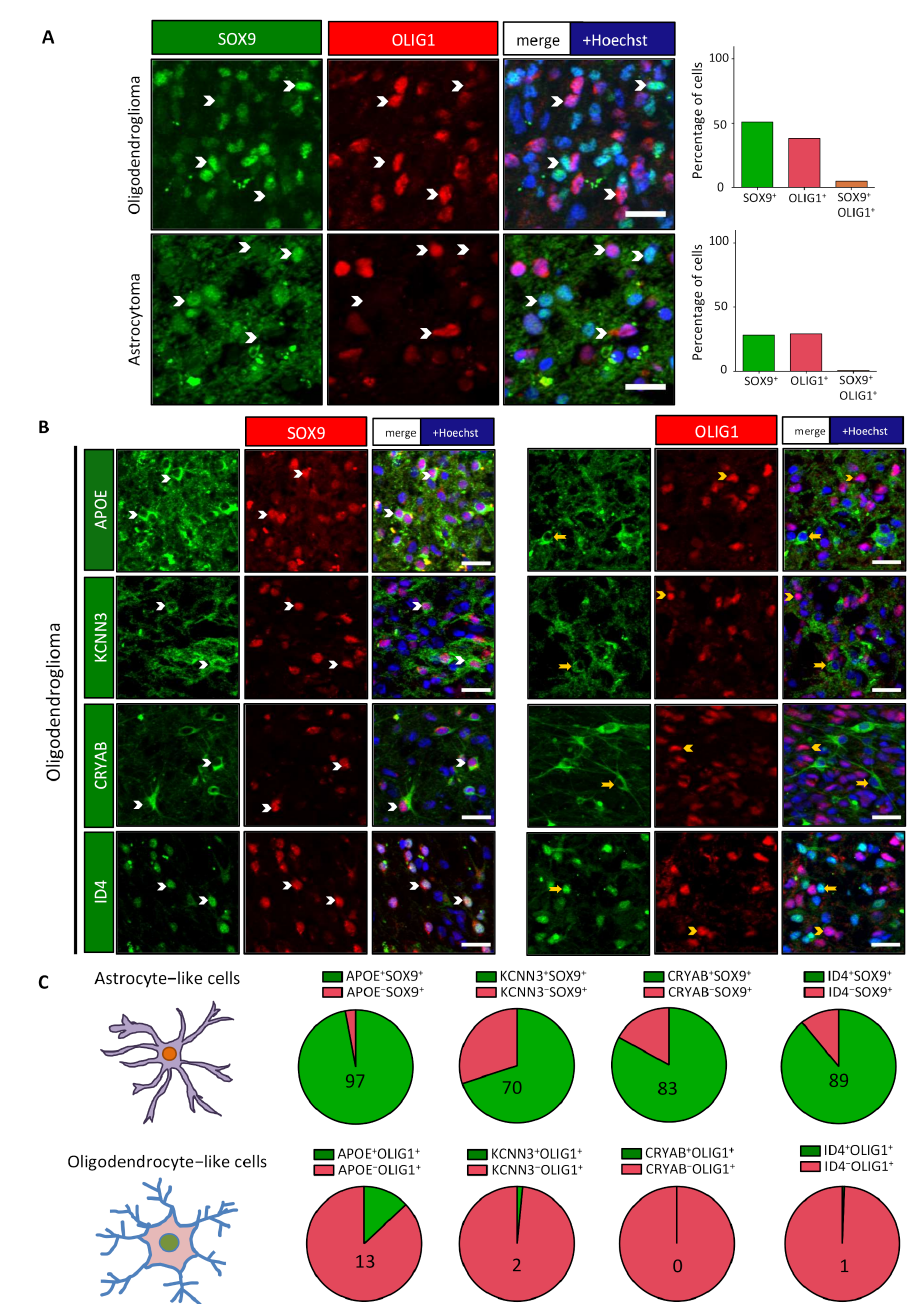
Figure 1. Two nonoverlapping cell subpopulations detected in IDH-DGIIG. ( A ) Immunofluorescence performed on one oligodendroglioma and one astrocytoma using antibodies against SOX9 (green) and OLIG1 (red) revealed the pres- ence of two nonoverlapping cell subpopulations. White arrowheads mark cells expressing either SOX9 or OLIG1 alone. Scale bars = 20 µ m. Bar diagrams show the percentage of SOX9 + cells (green), OLIG1 + cells (red), and percentage of cells double-positive for SOX9 + and OLIG1 + (orange) among the total number of cells. The two subpopulations were also detected in other cases (see Figure S2A). ( B ) SOX9 + cells show specific protein expression. Double stainings for APOE, CRYAB, KCNN3, and ID4 with SOX9 or OLIG1 showed their preferential expression in SOX9 + cells. White arrowheads identify double-positive cells, while yellow arrowheads/arrows represent single positive cells. Scale bars = 20 µ m. ( C ) Pie diagrams representing the percentage of double-positive (green) and single-positive (red) cells in SOX9 + (upper lane) and OLIG1 + (lower lane) populations. Numbers indicate the percentage of double-positive